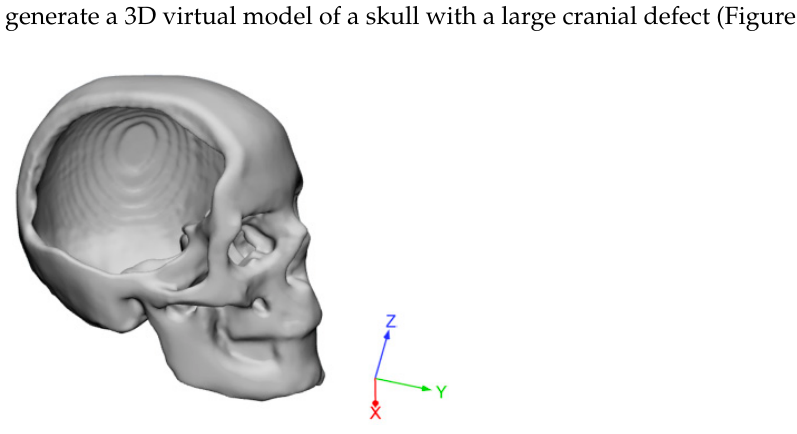
Figure 3. Three-dimensional geometrical models of a customized device for large cranial defect: non-porous model ( left ); model with interconnected pore network ( right ).